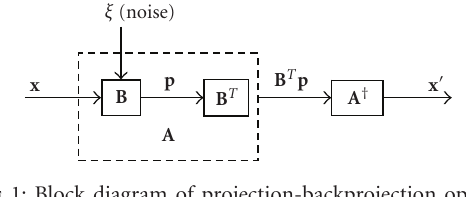
Figure 1: Block diagram of projection-backprojection operation. Noise is introduced at the projection operation, B . Image compo- nents which are “attenuated” in B and B T must be “amplified” in A † , increasing the noise in x (cid:2)